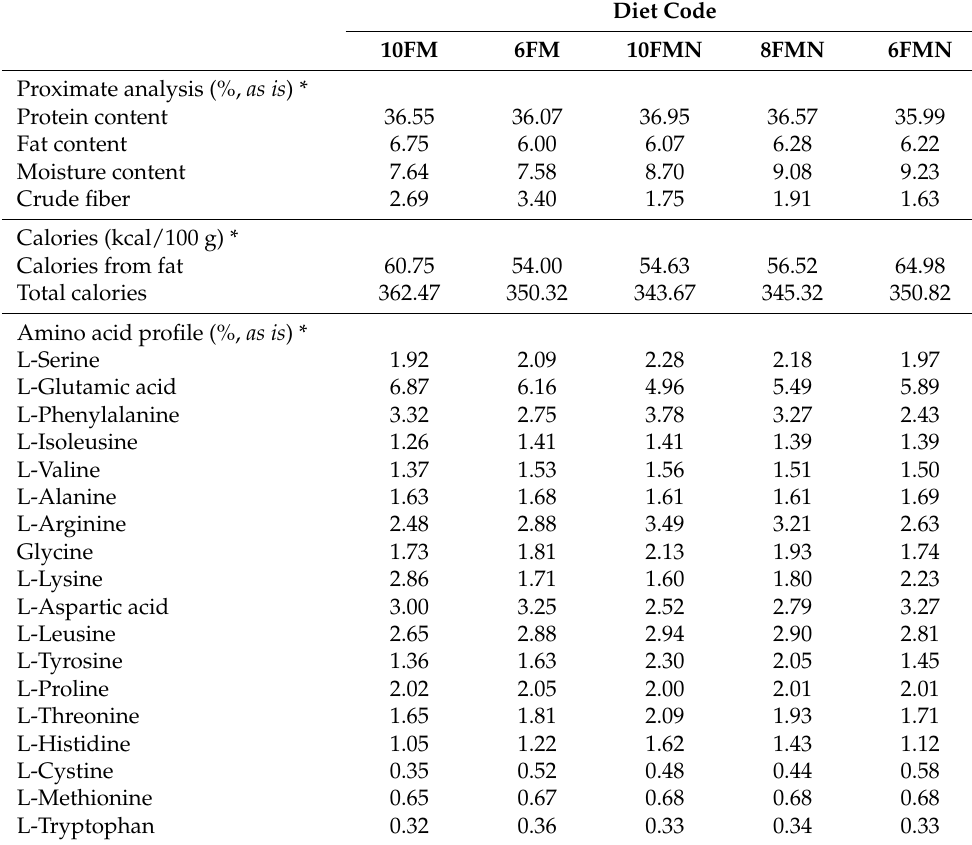
Table 2. Proximate analysis, calories, and amino acid (AA) composition (% as is , dry matter basis) of experimental diets utilized in this trial. Diets were administered to Pacific white shrimp (PWS) for 110 days, and were formulated using different levels (10%, 8% and 6%) of fish meal (FM), and with or without adding dietary nucleotides